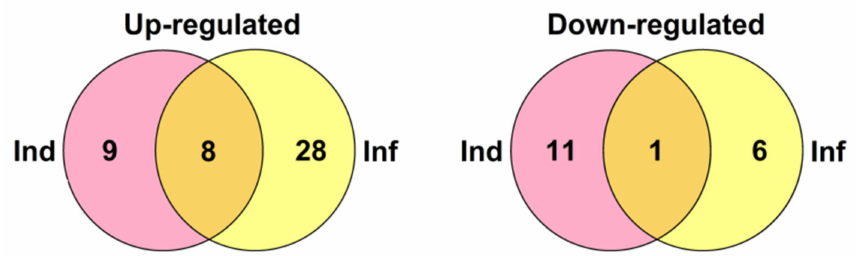
Figure 21. Venn diagram showing the number of CRP genes specifically up- or down-regulated in IR-displaying plants compared to elicitor-treated (Ind) and F. oxysporum -infected at 4 dpi (Inf) seedlings as well as similarly expressed genes in both transcriptomes. For up-regulated genes, expression fold change was ≥ 2, for down-regulated, it was ≤